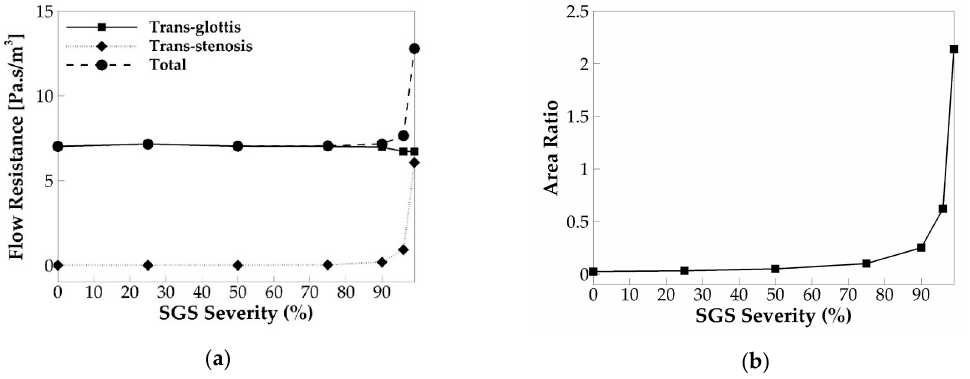
Figure 13. ( a ) The cycle-averaged trans-glottis, trans-stenosis, and total flow resistance versus SGS severity. ( b ) The ratio of the cycle-averaged glottal area to the SGS area versus SGS severity.